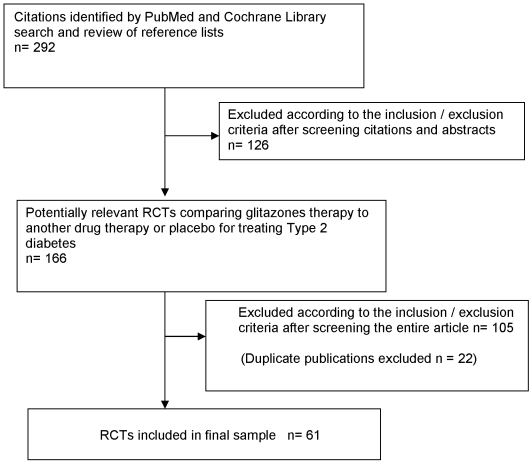
Flowchart for Manuscript selection/ and inclusion.